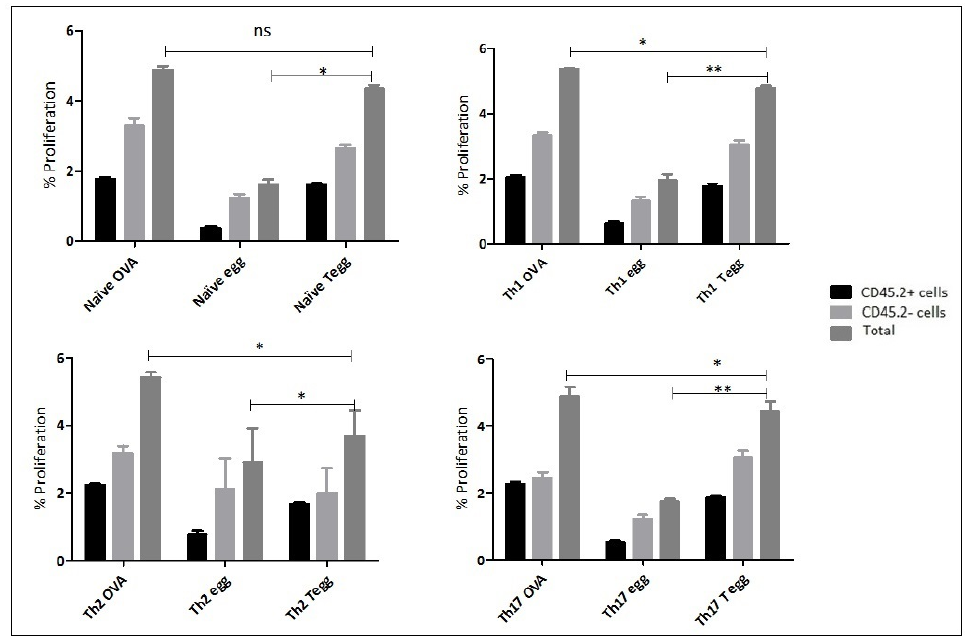
Figure 2. Naïve OT-II T cells were first differentiated into Th1, Th2 and Th17 cells using polarising cytokines and a total of 2 × 10 6 each polarized cells were adoptively transferred into congenic mice. After 48 h, each recipient mice were challenged with either OVA protein (30 µ g/mL) or 1000 OVA-expressing eggs or 1000 wild type eggs. After seven days, mice were culled to recover memory Th cells from spleen and lymph nodes. After recovery, the cells were re-stimulated in vitro with the same preparation as the initial in vivo stimulation and proliferation was assessed using the CFSE method and CD4 surface staining. The abbreviation naïve, Th1, Th2, and Th17 followed by words such as OVA, egg, and Tegg represents an initial injection of the cells into recipient mice and later challenged by the antigens, OVA protein, untransduced eggs, OVA expressing eggs, respectively. Single * ( p < 0.05) and double ** ( p < 0.01) in the graph represents the value statistical association among the dependent and independent variables and “ns” represents no statistical significance. The experiment in this study were performed in triplicates and the statistical association between different dependent and independent variables was analysed using t -test. The proportion (%) in the Y -axis represents the total number of proliferated T helper cells following antigen stimulation for each type of cells injected into the mouse and a challenge of that mouse with the different antigens ( X